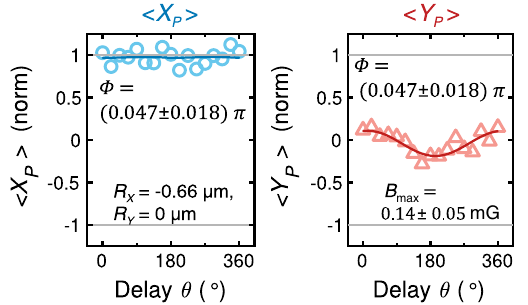
FIG. 10. Minimum photocurrent density measured. Data set showing a small phase acquired on device B for a total of 2 hours of averaging time. The sensing sequence here is XY8-2, with τ ¼ 9 μ s, P ¼ 6 μ W, and B 201 G. The extracted maximal ext ¼ phase Φ ¼ ð 0 . 047 (cid:3) 0 . 018 Þ π corresponds to a maximal projected 0 . 14 (cid:3) 0 . 05 mG using field along the NV center axis of B max ¼ β ≈ 1 . 2 (estimated from the θ of the data set). This case opt corresponds to the field produced by a uniform sheet current ≈ 20 nA = μ m flowing perpendicularly to the density J sheet NV axis.